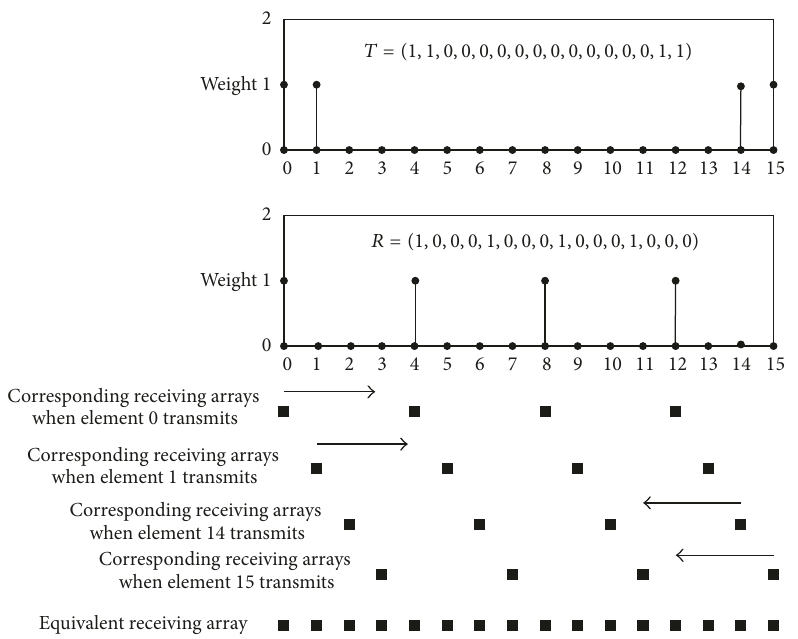
Figure 6: “4-transmitter 4-receiver” transmitter-receiver array and the equivalent receiving array.